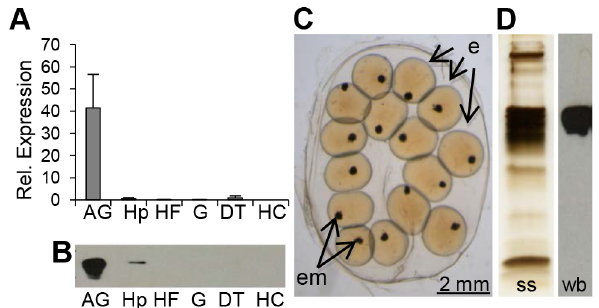
Figure 1. BgLBP/BPI1 is expressed in the albumen gland and is the major protein of B. glabrata egg masses. (A) Relative expression levels of BgLBP/BPI1 transcripts in the albumen gland (AG), hepatopancreas (Hp), Headfoot (HF), gonads (G), digestive tract (DT) and circulating hemocytes (HC) determined using real-time quantitative PCR (data from 3 independent experiments). Expression has been normalized to expression of S19 and EEF1- a reference genes. (B) Representative western blot showing the content in BgLBP/BPI1 protein in 15 m g total protein from the corresponding snail tissues (legend as in (A). (C) Typical live 2-days old B. glabrata egg mass with eggs (e) containing embryos (em) observed under a phase-contrast reversed microscope. (D) Total egg mass protein content as revealed by silver staining (ss) and egg mass BgLBP/BPI1 revealed by western blot (wb) using a custom-made antibody raised against two BgLBP/BPI1 peptides.